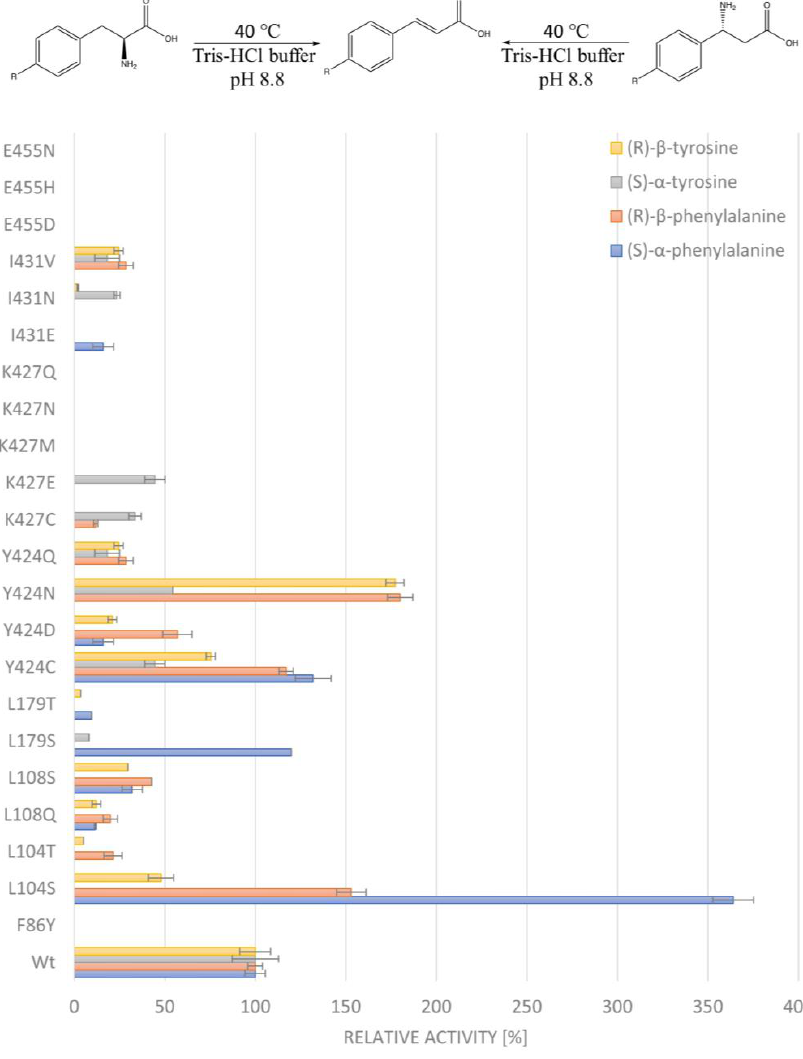
Figure 2. Deamination of different aromatic amino acids as a substrate for cinnamic acid or p-hydroxycinnamic acid by the mutant candidates from the computationally designed library. No activity was detected in the mutants without bars.